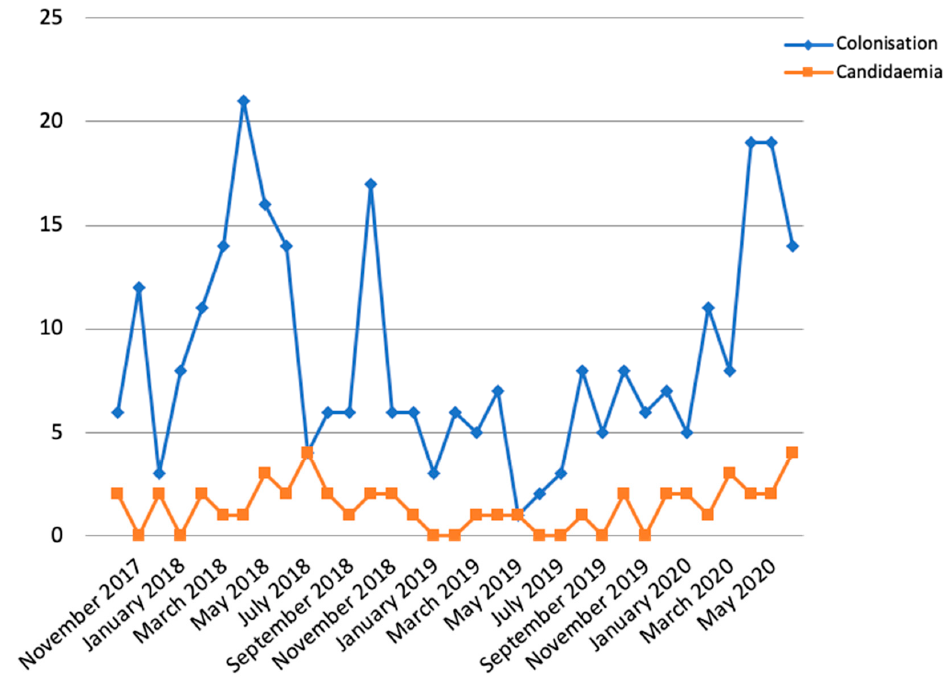
Figure 1. New colonised patients and candidaemia episodes from October 2017 to June 2020.